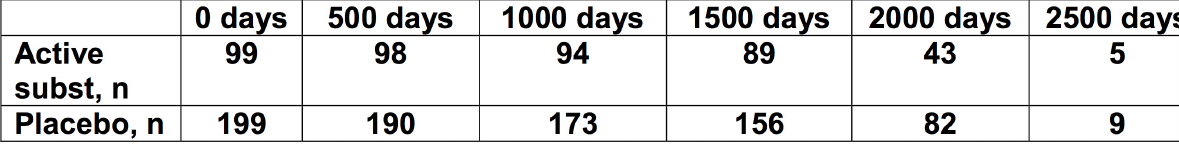
PLOS ONE | DOI:10.1371/journal.pone.0157541 July 1,